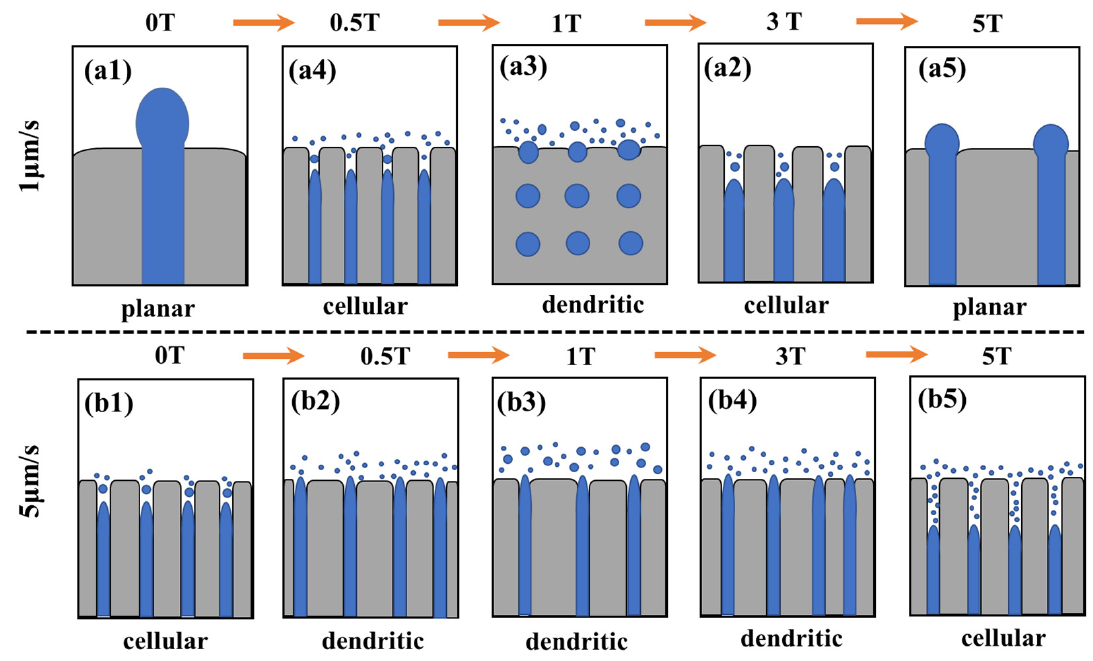
Figure 5. Schematic diagrams of the morphological evolution of the S-L interface in the ingots directionally solidified at growth rates of 1 µ m/s and 5 µ m/s, respectively, under various MFDs. ( a1 – a5 ) 1 µ m/s; ( b1 – b5 ) 5 µ m/s. The Bi-rich phases are colored in blue, and the Zn- rich matrixes are colored in grey.